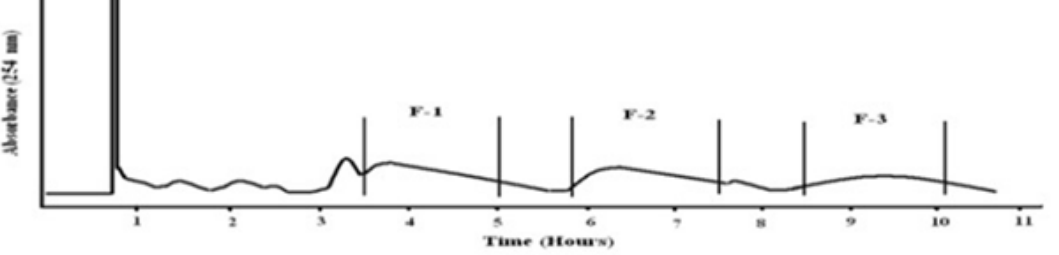
Figure 2: HSCCC separation 2 of theaflavin curde extract from black tea (254 nm), Solvent system Hex:EtOAc:MeOH:water (1:5:1:5) elution 2.0 mL/min, 800 rpm, sample size 200mg